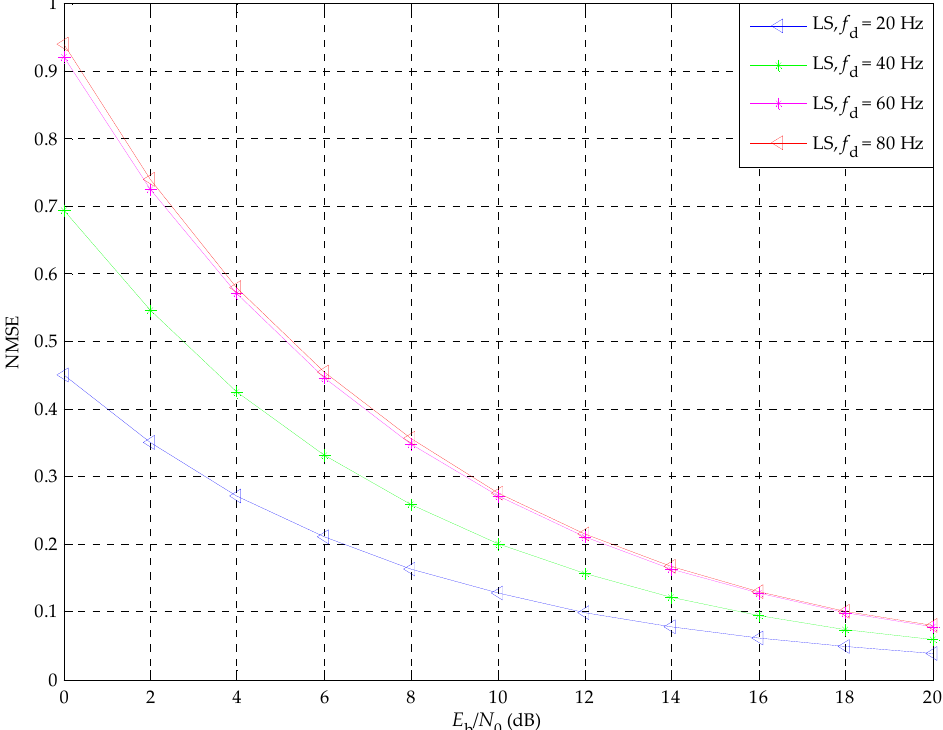
Figure 7. NMSE performance of the OFDM/QPSK system over Rayleigh fading channels with Doppler spread of 20, 40, 60, and 80 Hz.